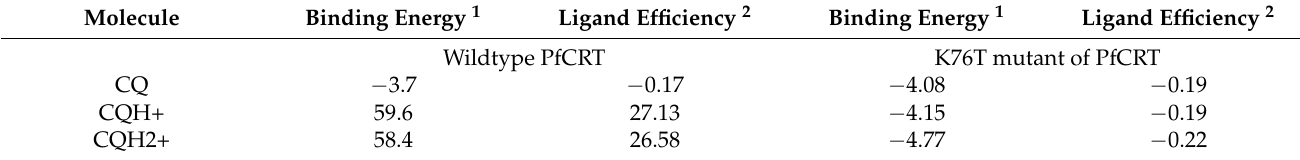
Figure 4. Most stable docking pose of different ionic forms of CQ bound to the mutant PfCRT receptor. Please note the binding of the protonated forms of CQ to the wildtype protein is on the outside surface, while for the K76T mutant, the binding sites of different ionic forms of CQ are very close to each other. Table 3. Docking energy of neutral and protonated CQ to PfCRT